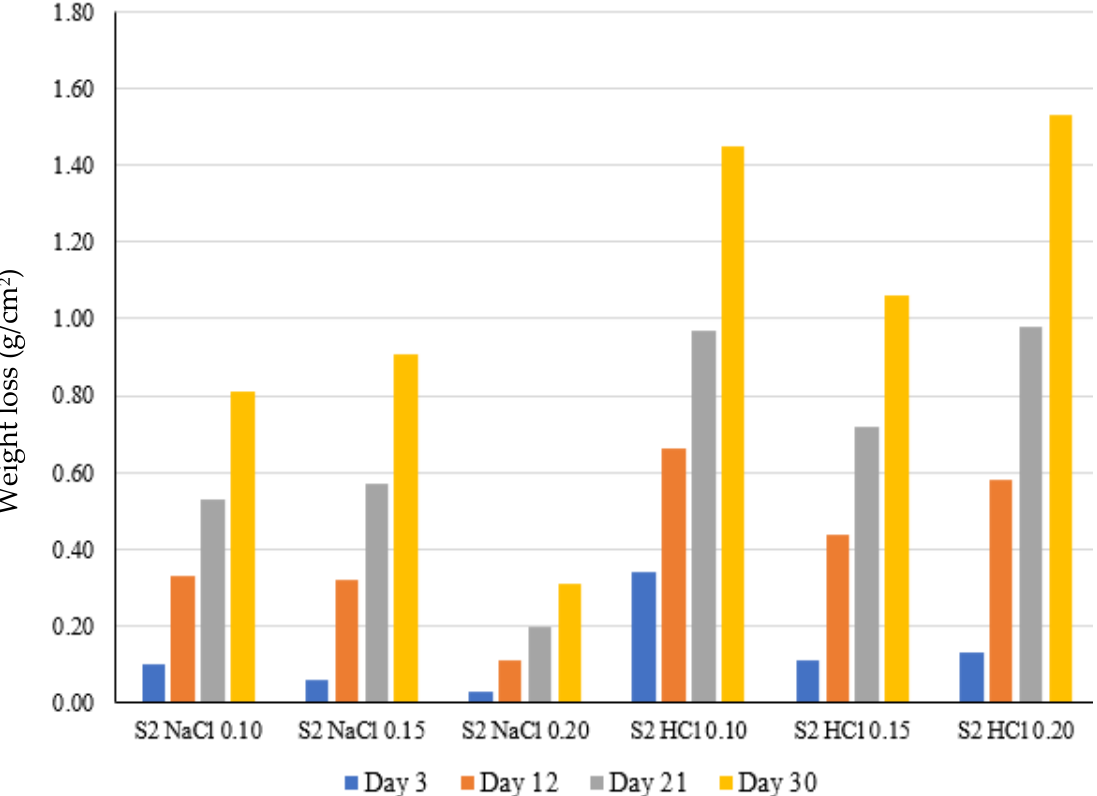
Figure 2. Effect of AgNp + CaCO 3 on corrosion behaviour of S 2 (4%).